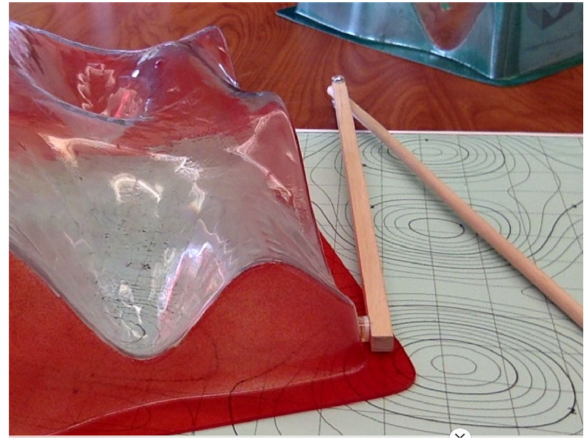
FIG. 2. A plastic surface and matching contour map used in a variety of activities aimed at improving students ’ understanding of multivariable